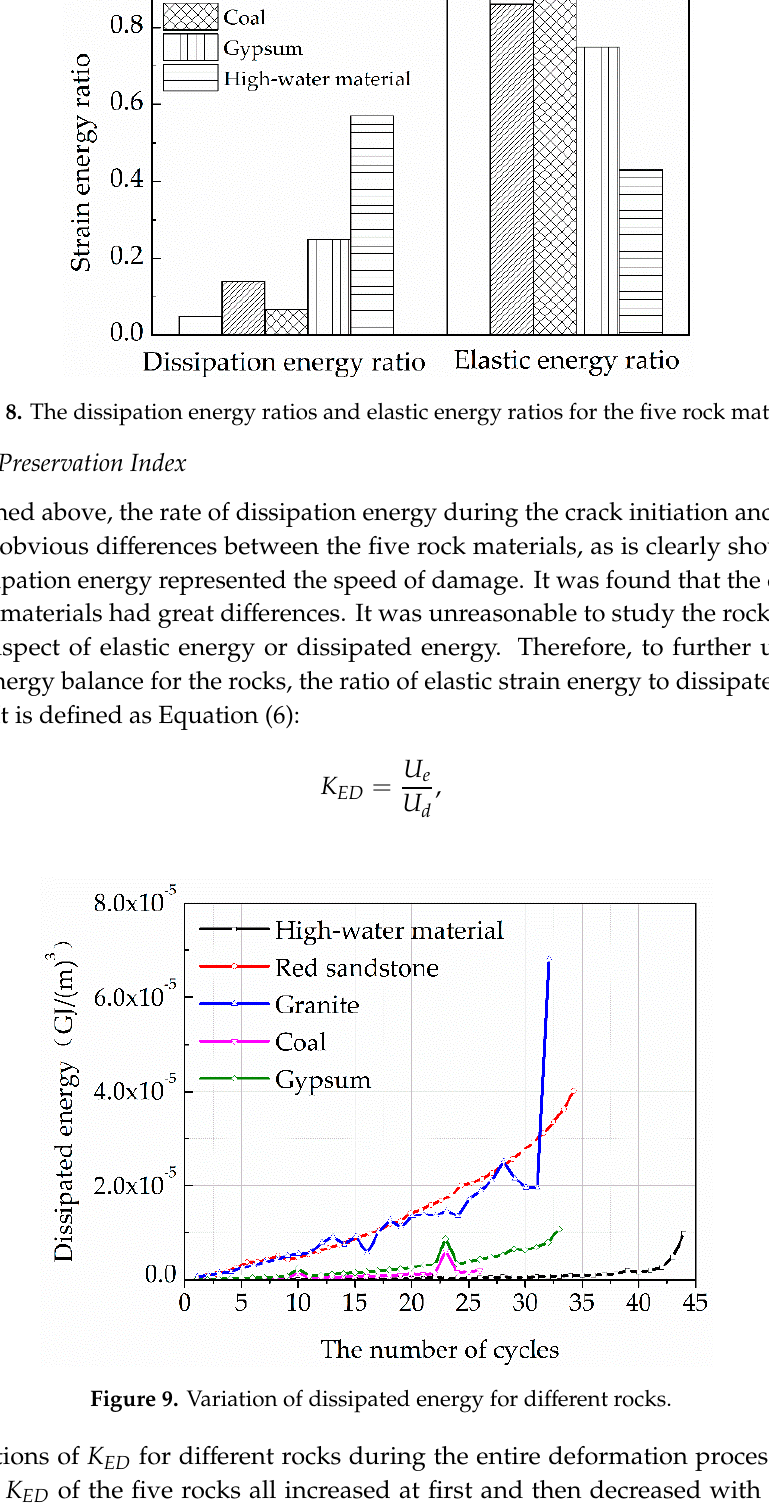
Figure 10. Evolution of the ratio of elastic strain energy to dissipated energy ( ED K ) for the rocks.